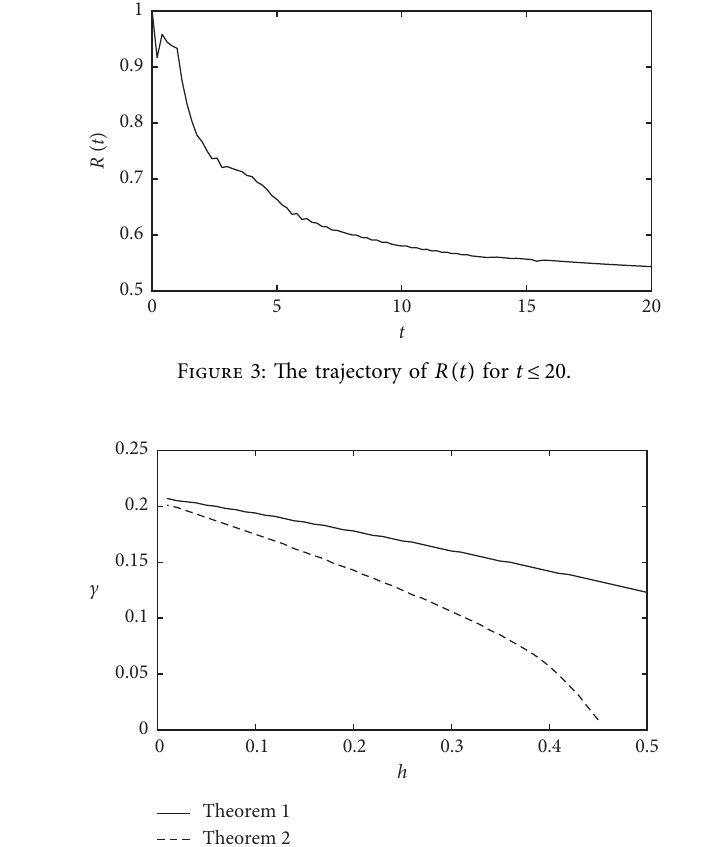
Figure 4: The maximum c which allows the existence of feasible solutions for Theorems 1 (the solid curve) and 2 (the dashed curve), when the sampling period h is changing from 0.01 to